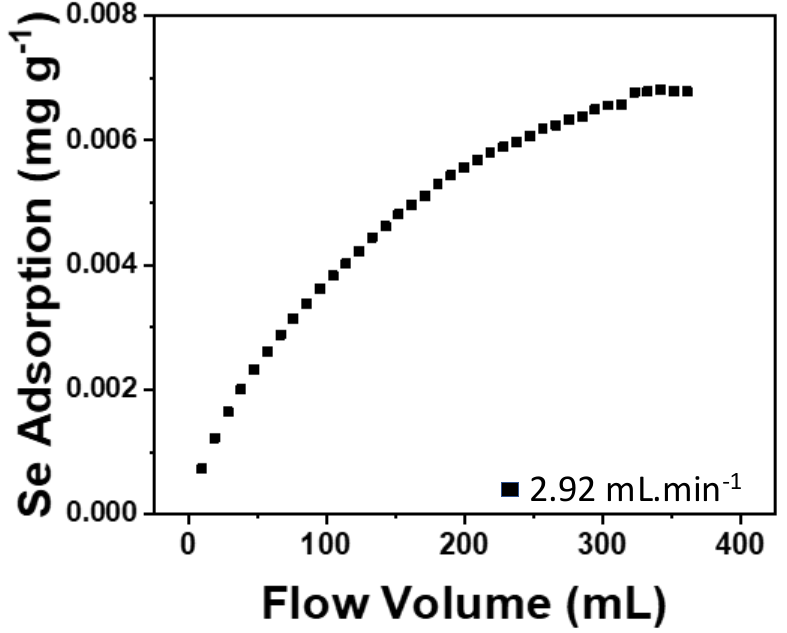
Figure 6. Adsorption of Se in sand as a control for inert column materials present.